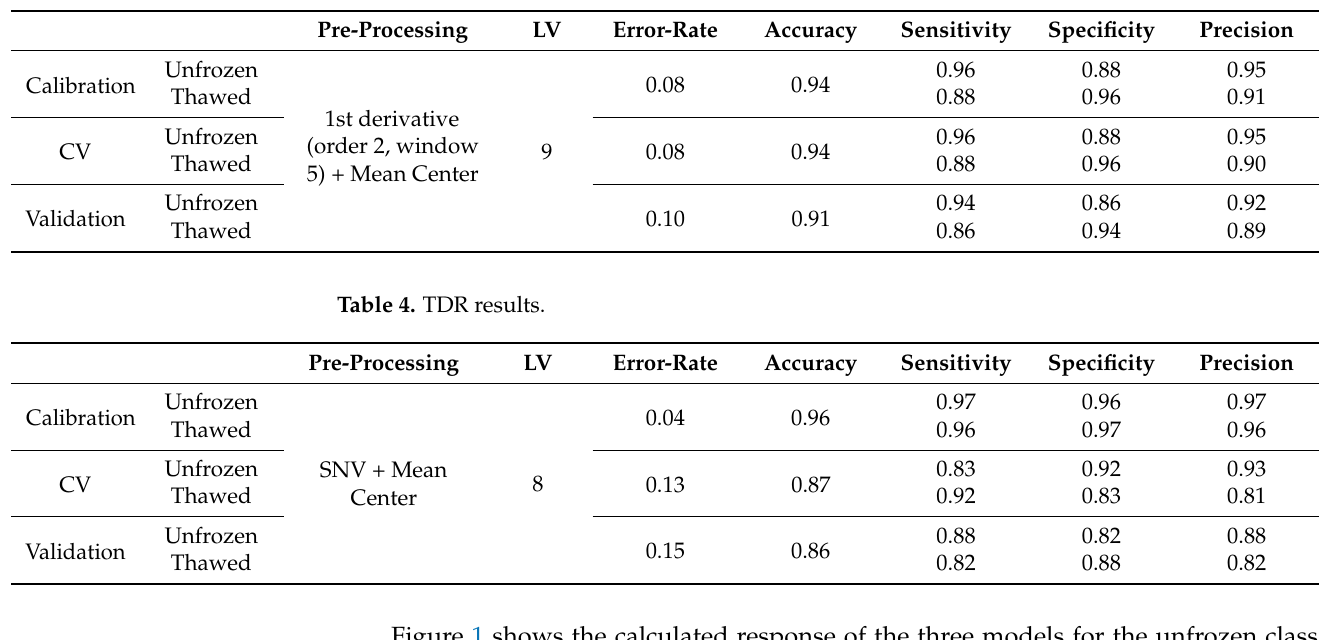
Table 3. NIR results.